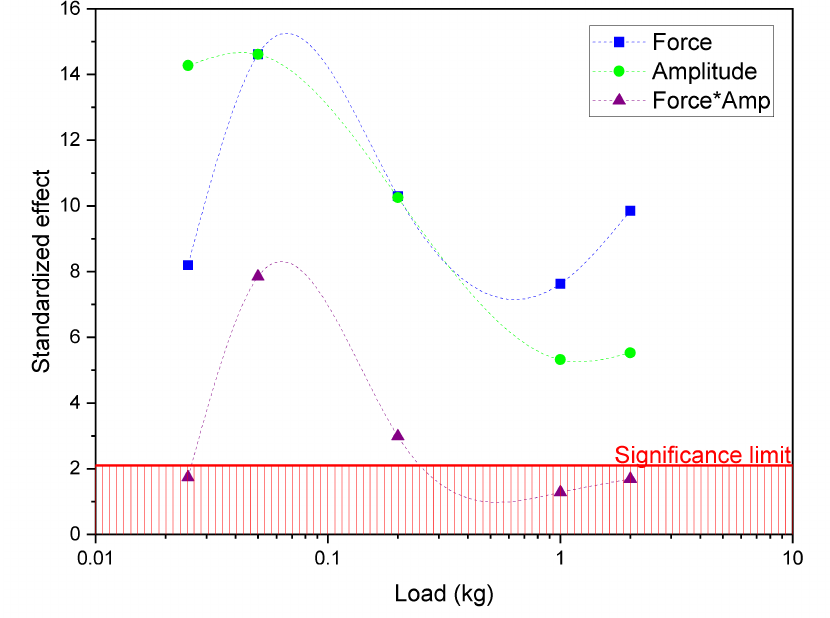
Figure 5. Standardized effect of all parameters vs. Vickers indentation